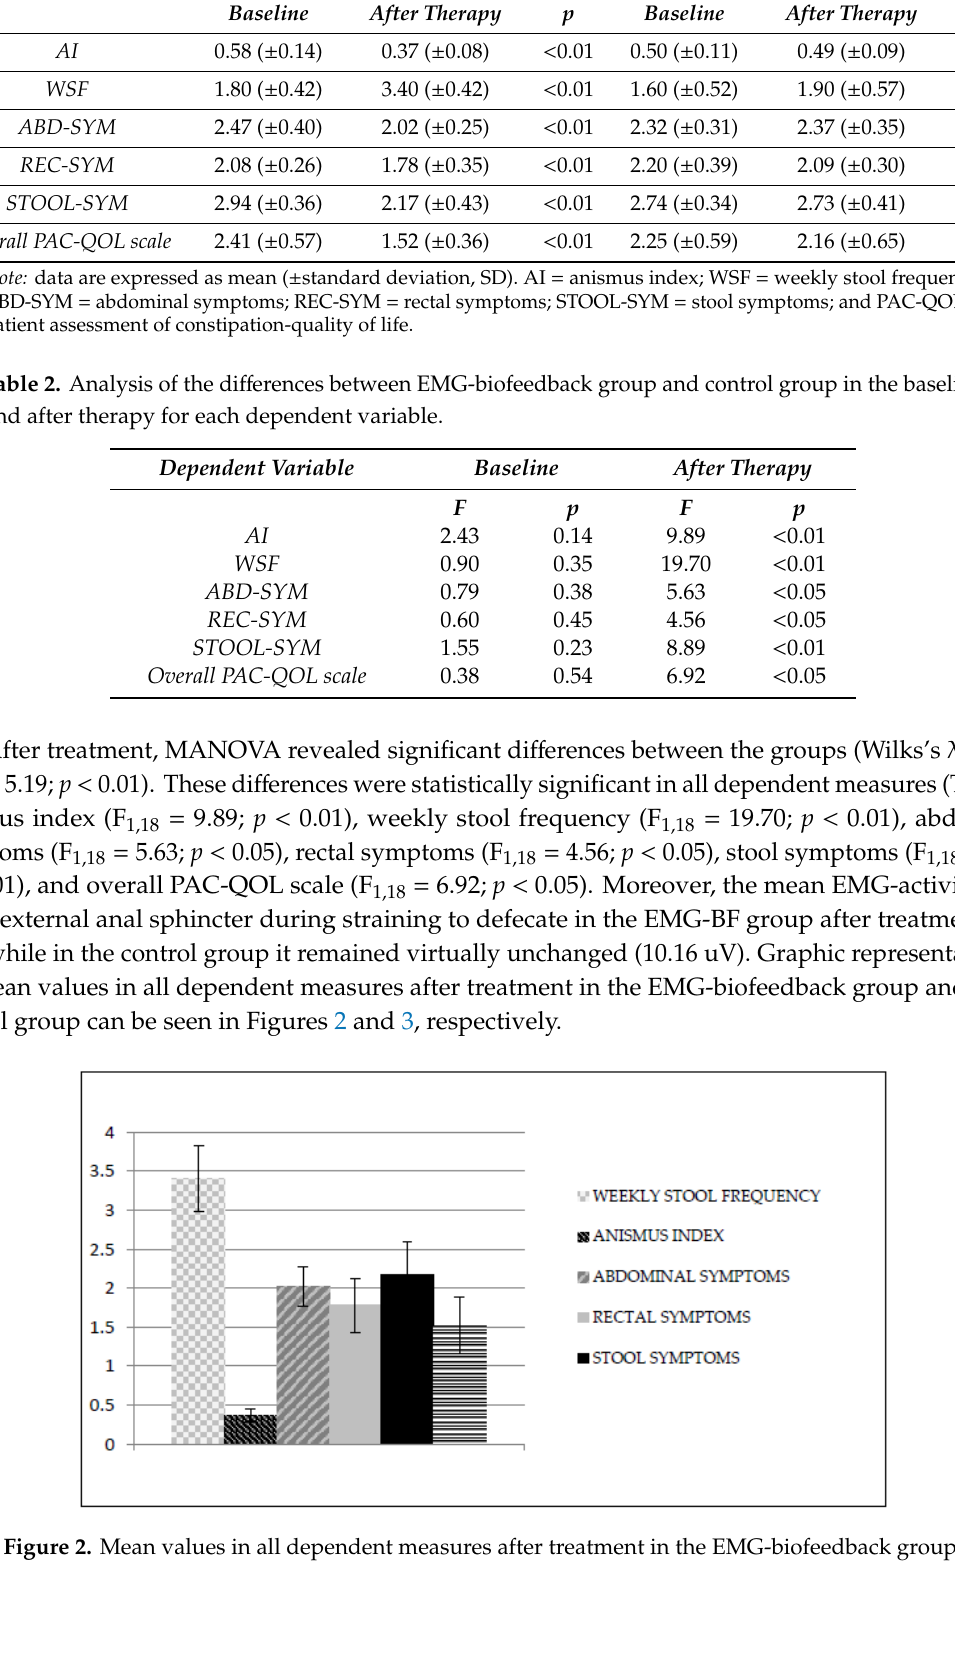
Table 1. Anismus index, weekly stool frequency, clinical symptoms, and overall quality of life (QOL) measure before and after treatment in the electromyographic biofeedback (EMG-biofeedback) group and control group.